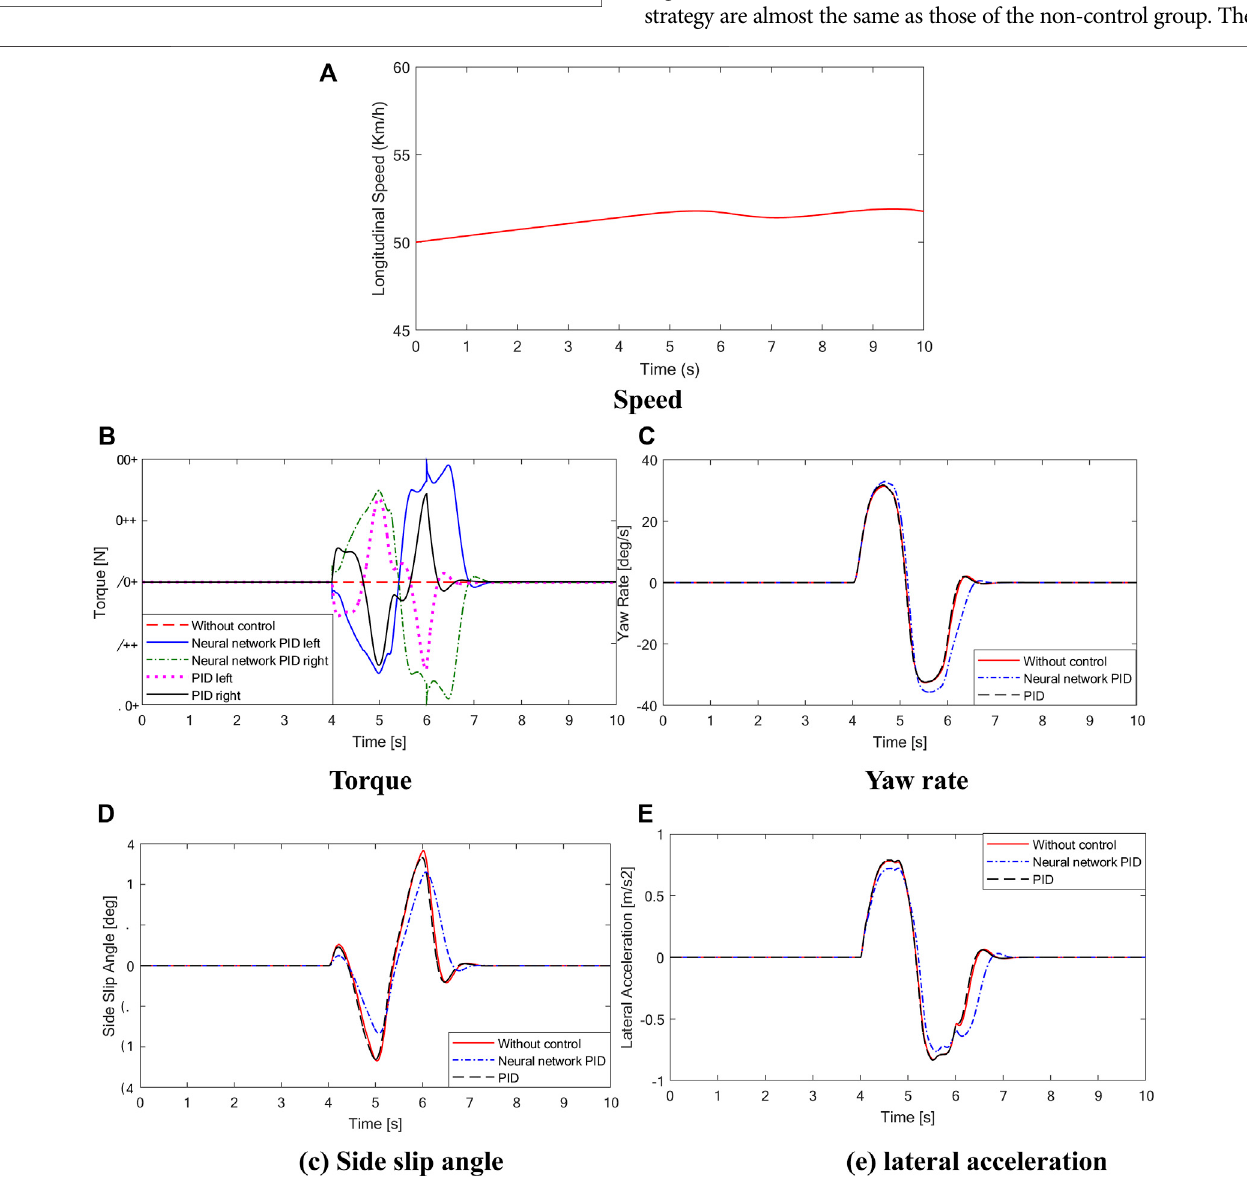
FIGURE10| Simulationresults. (A) isthelongitudinalspeedcurve, (B) isthetorque curve, (C) istheyawratecurve, (D) isthesideslipangle curve, (E) isthelateral acceleration curve.